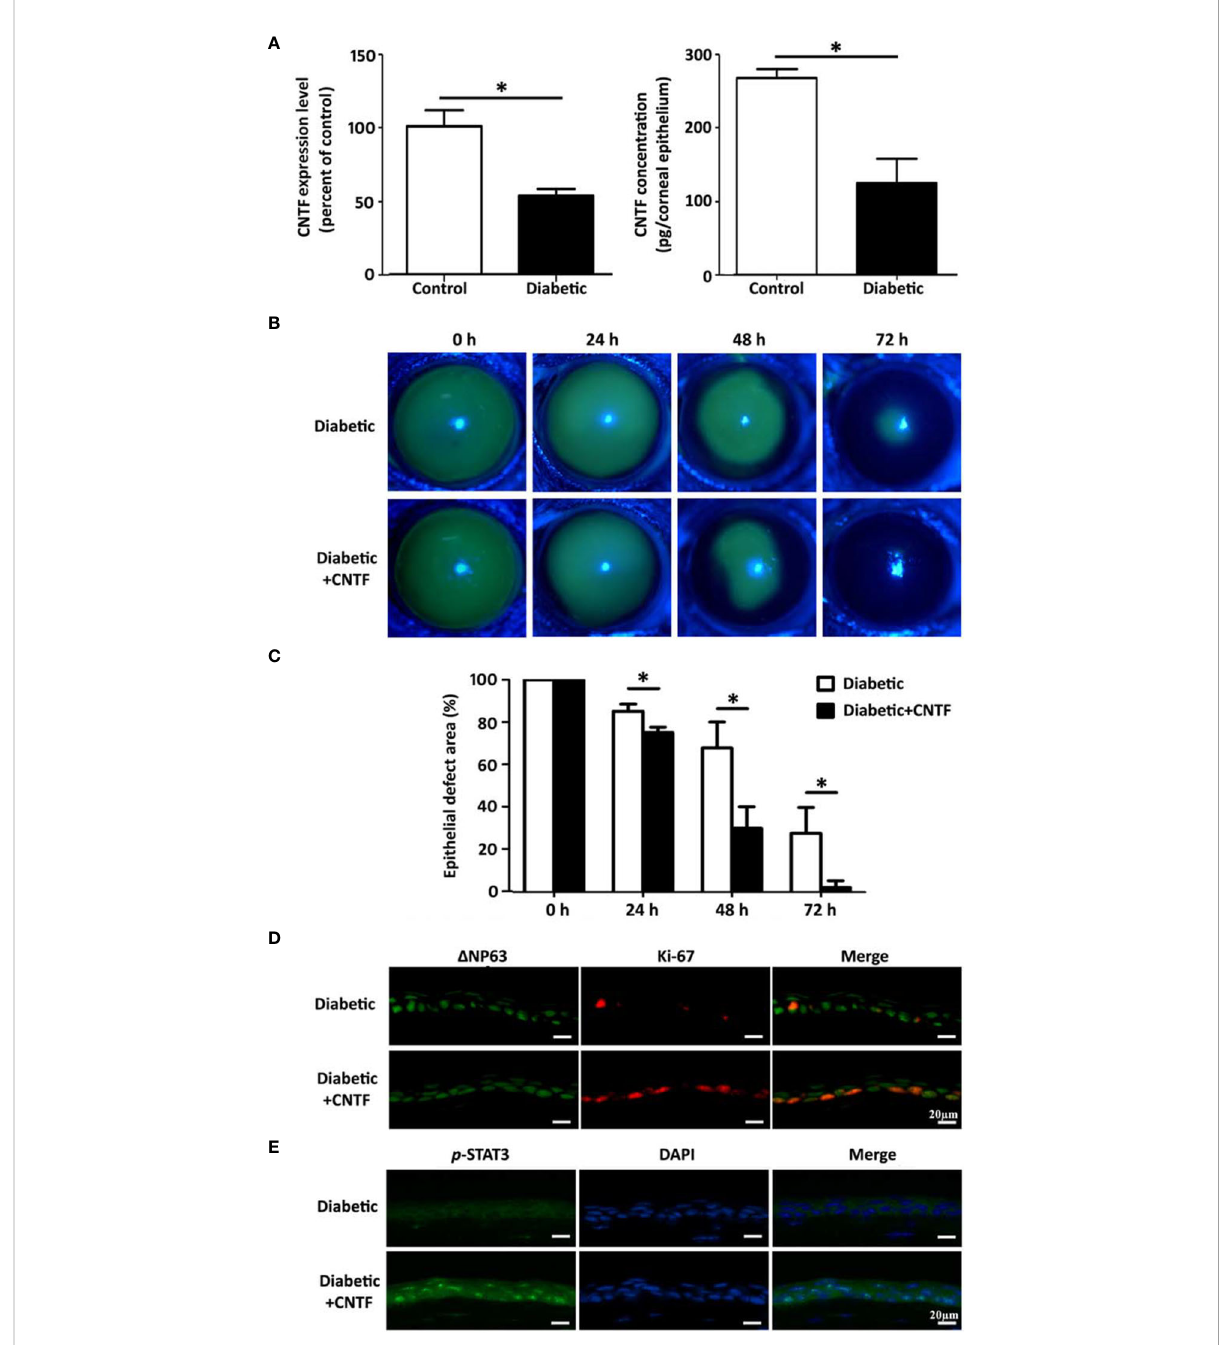
FIGURE 3 CNTF promotes corneal epithelial wound healing in diabetic mice. (A) CNTF is decreased in diabetic corneas both in mRNA and in protein level. (B, C) Subconjunctival injection of 50 ng CNTF signi fi cantly promotes the corneal epithelial wound healign in diabetic mice. (D) The expression of D Np63 and Ki-67 in the regenerating corneal epithelium is upregulated after CNTF treatment. (E) CNTF activated Stat3 signaling in diabetic wounded corneas. "*p< 0.05. (ref